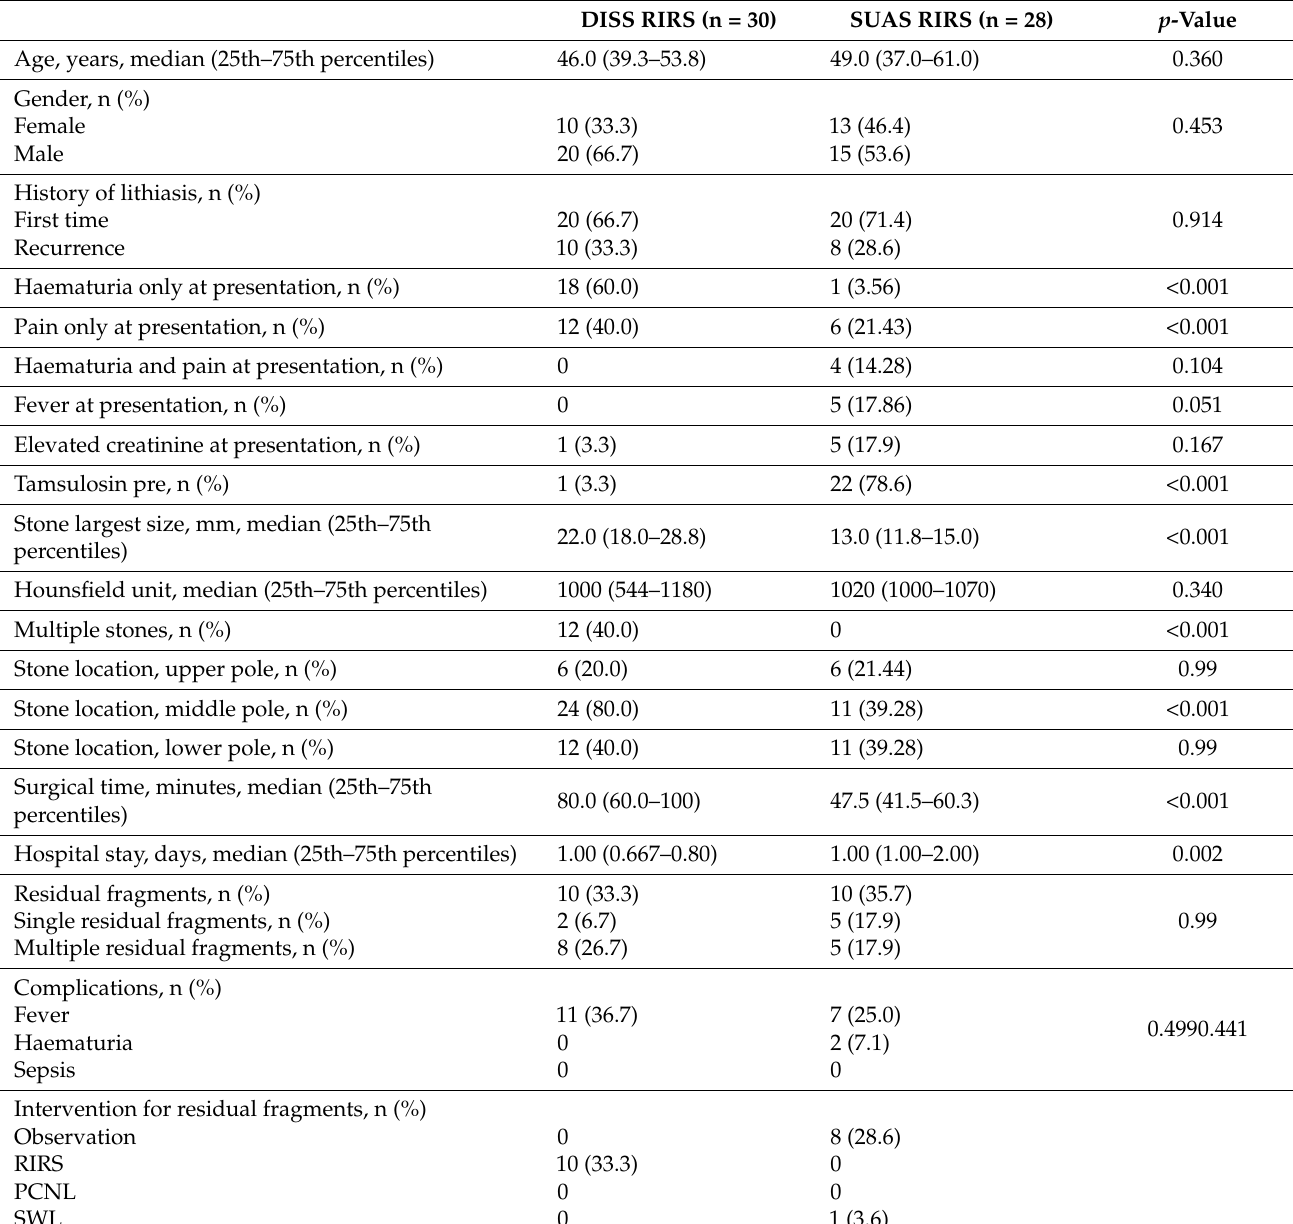
Table 1. Patients’ characteristics. RIRS: retrograde intrarenal surgery. PCNL: percutaneous nephrolithotripsy. SWL: shock wave